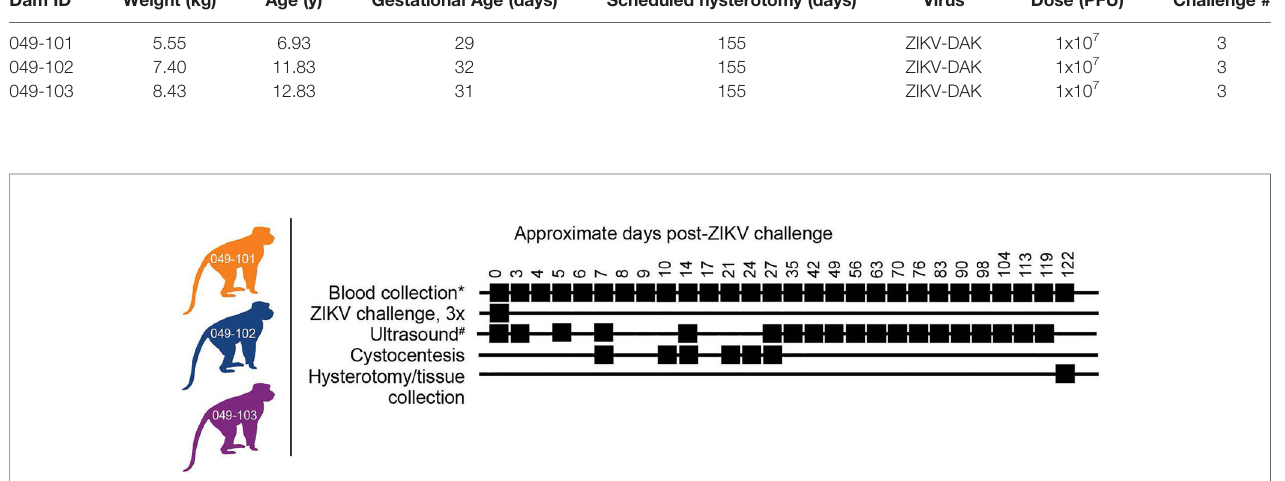
FIGURE 1 | Study design. Three female rhesus macaques were time-mated, con fi rmed pregnant by ultrasound, and challenged intravaginally at 30 days (+/-2) gestational age with 1x10 7 PFU ZIKV-DAK three times at two-hour intervals. Blood collection* denotes plasma and PBMC isolation at every sampling time point while serum collection was planned only on days 0, 14, 27, and 122 post-ZIKV challenge. Ultrasound # denotes ultrasound imaging was performed every 3-4 days during early gestation, then weekly thereafter. Hysterotomies were originally planned for each animal at approximately 122 days post-ZIKV challenge.